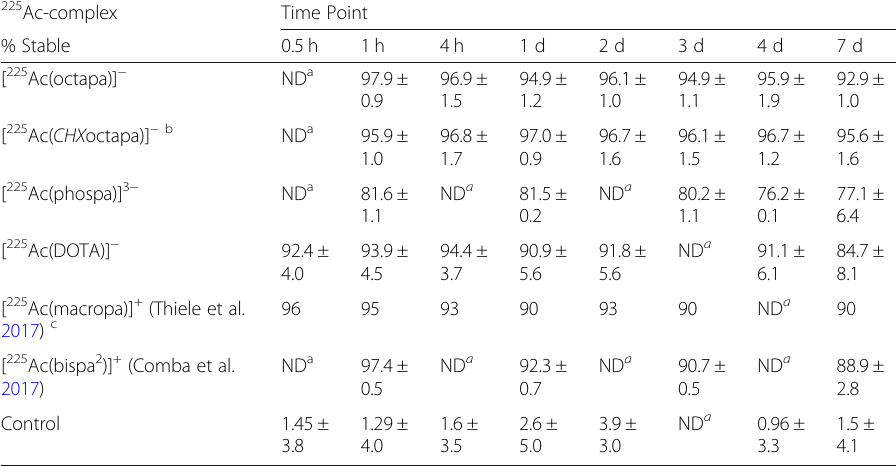
Table 3 Stability of 225 Ac-labelled chelate complexes in human serum at ambient Temperatures ( n = 3 unless otherwise noted)